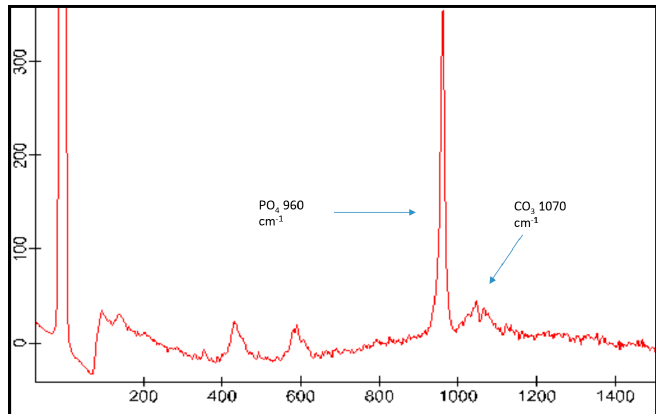
Figure 2. EDX elemental mapping of the HA nanoparticles ( a ) showing evidence of oxygen ( b ), calcium ( c ), and phosphorus ( d ) in the hydroxyapatite samples.